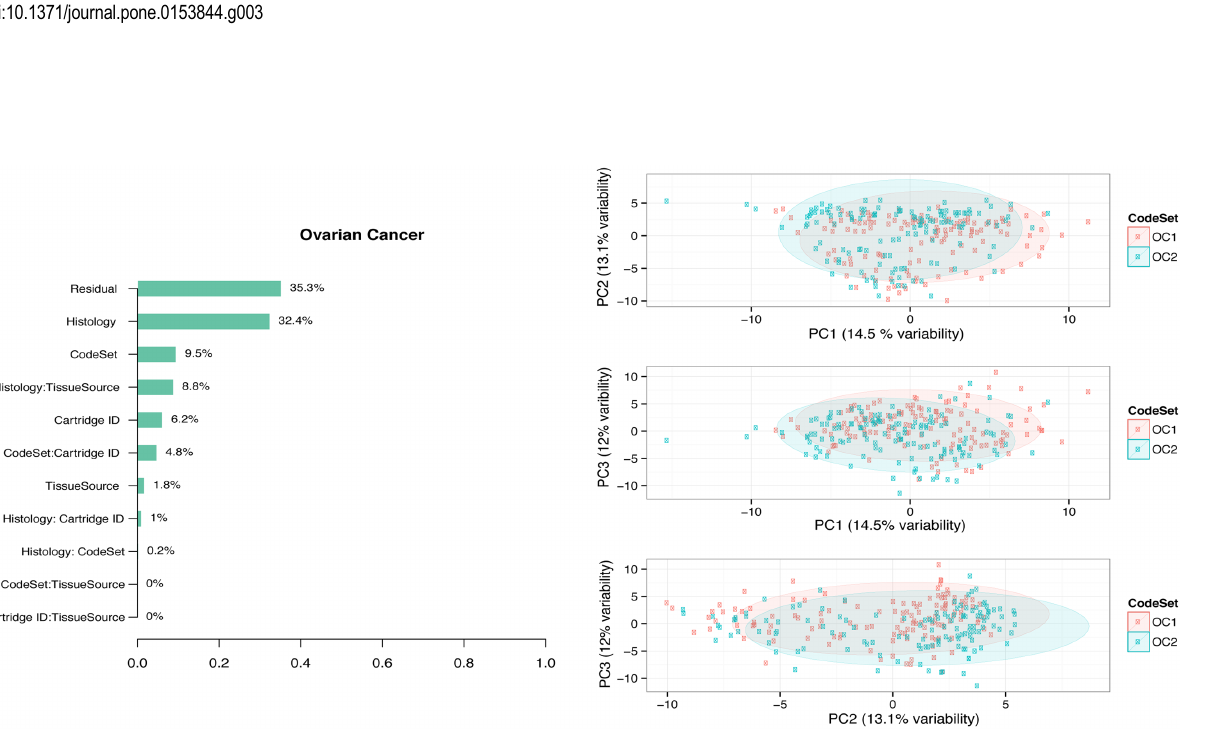
PLOS ONE | DOI:10.1371/journal.pone.0153844 April 20, 2016 10 /